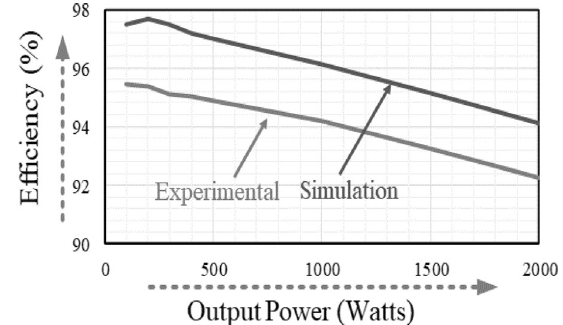
Figure 5. Efficiency curves of the proposed topology.